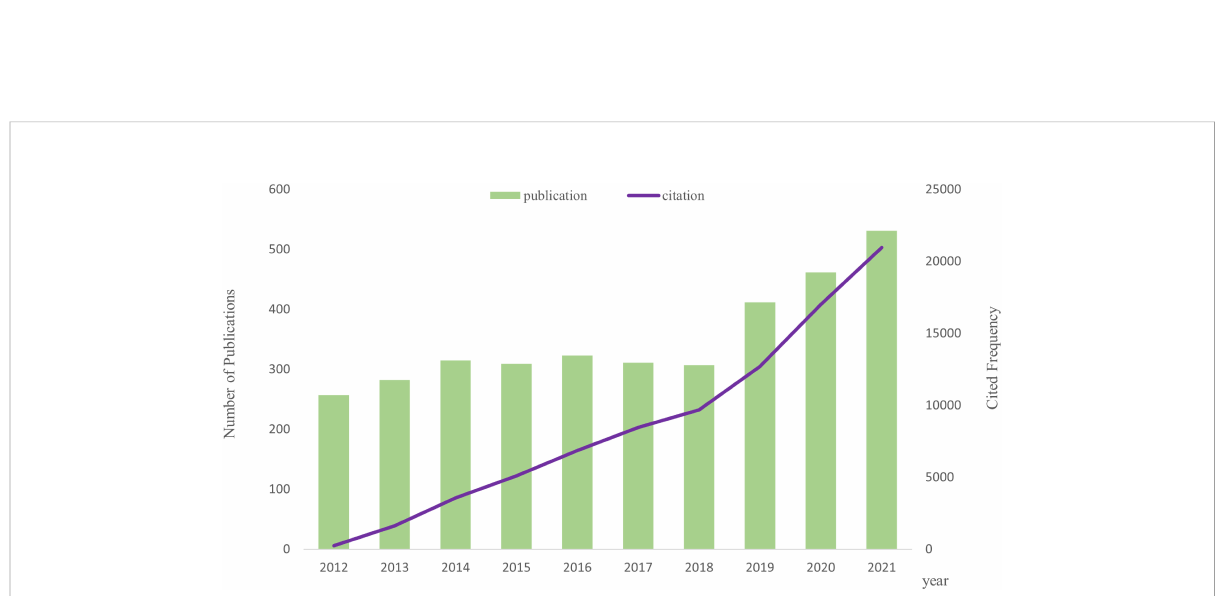
FIGURE 2 Tendency via bar and line graphs of alternative splicing of cancer publications and cited frequency nearly 10 years.